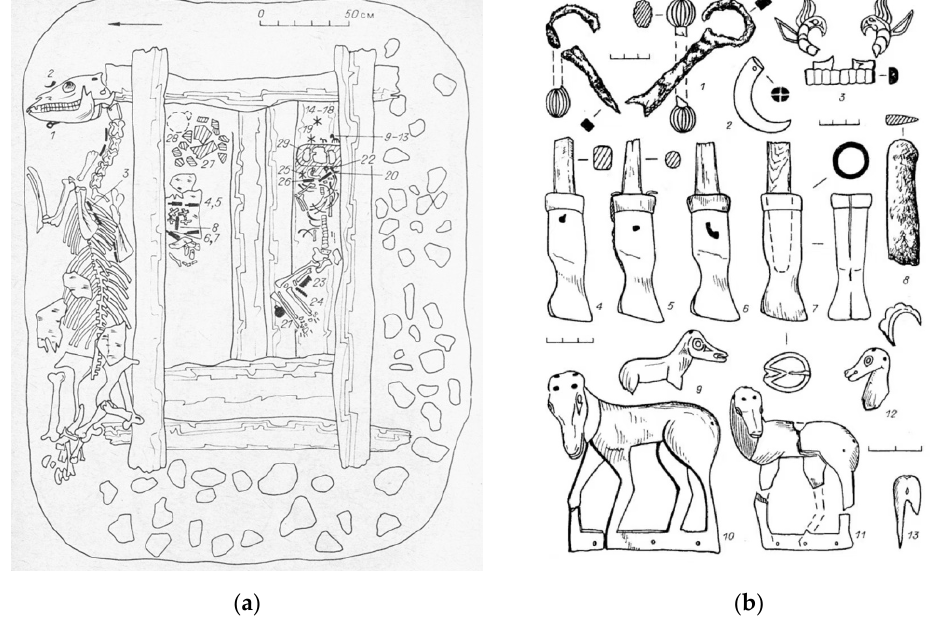
Figure 6. ( a ) Ground plan, Yustyd XII, kurgan 19 (adapted from Kubarev 1991, PL XLIV). The deceased is identified as female because of the black stain remaining from her wig. Nos. 9–13 are